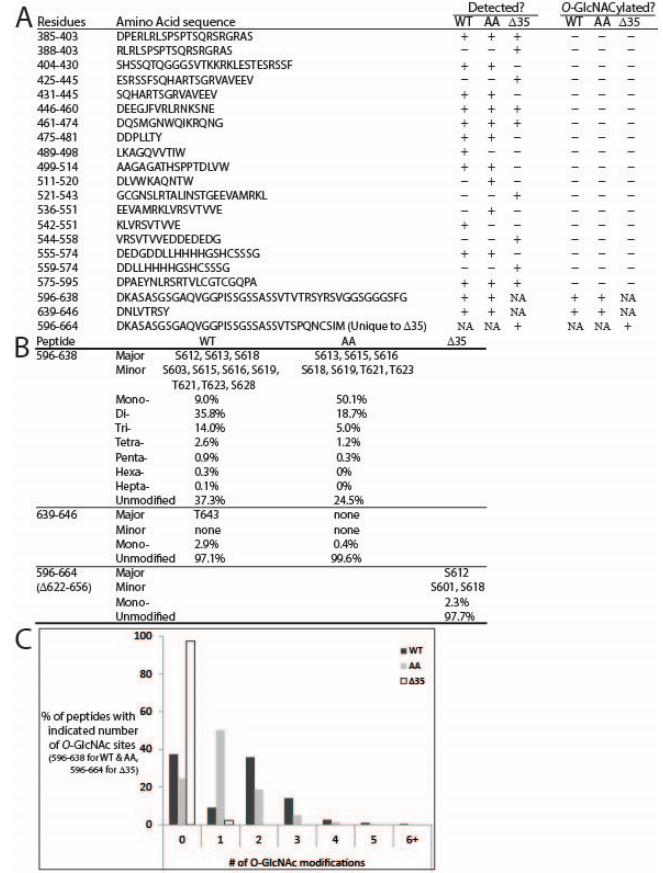
Figure 3. Mass spectrometry identification of O -GlcNAc sites in recombinant lamin A tail